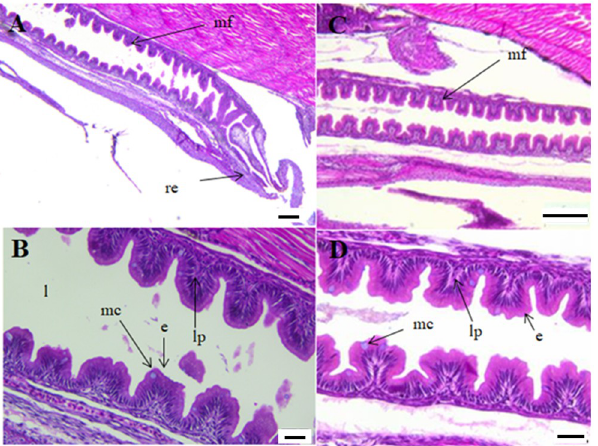
Fig 6. Longitudinal sections of posterior intestine of diploid and triploid Atlantic salmon at start-feeding (0 ddPSF). (A) Posterior intestine (2n). (B) Detail of posterior intestine (2n). (C) Posterior intestine (3n). (D) Detail of posterior intestine (3n). e. enterocytes; l. lumen; lp. lamina propria; mc. mucus cells; mf. mucosal folds; re. rectum. Scale. A,C. 200 μ m. B,D. 50 μ m.